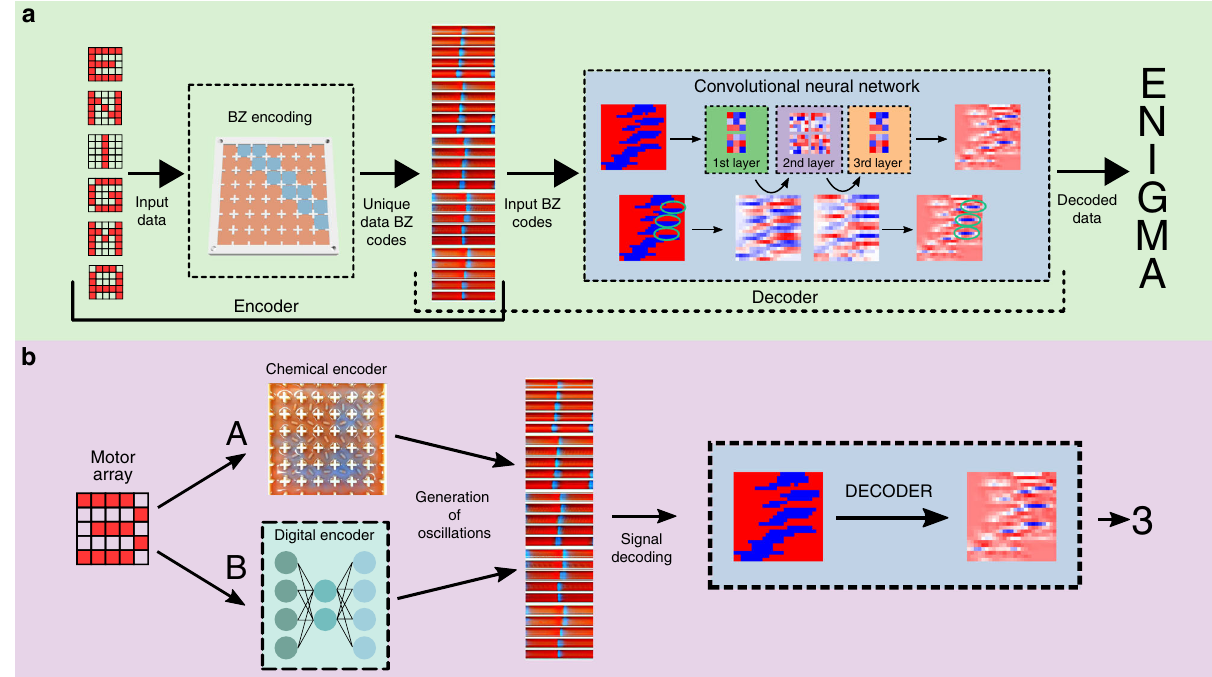
Fig. 4 Pattern classi fi cation and data encoding by BZ reaction and machine learning. a Schematic showing the full working pipeline of our system. Initially the user selects an input pattern, and this pattern is binarized in a 5-by-5 matrix. This matrix is used as a source for the PWM generator, and this will eventually generate a global oscillation. These oscillations are then decoded when needed for pattern recognition. b Flow diagram of the pattern recognition process comparing the BZ oscillations produced by a digital encoder and by the BZ platform. The A path uses the BZ medium as described above. The B path uses a digital encoder that has been trained beforehand in order to digitally produce BZ oscillations from motor patterns. Once the oscillations are generated using the BZ platform or the digital encoder, they are correctly decoded using a decoder as shown in ( a ). Both in ( a ) and ( b ), a snapshot of an oscillation is shown. The vertical axis of this snapshot represents each of the 25 cells, while the horizontal axis represents time. This snapshot was made juxtaposing consecutive frames to better represent the temporal domain of the BZ